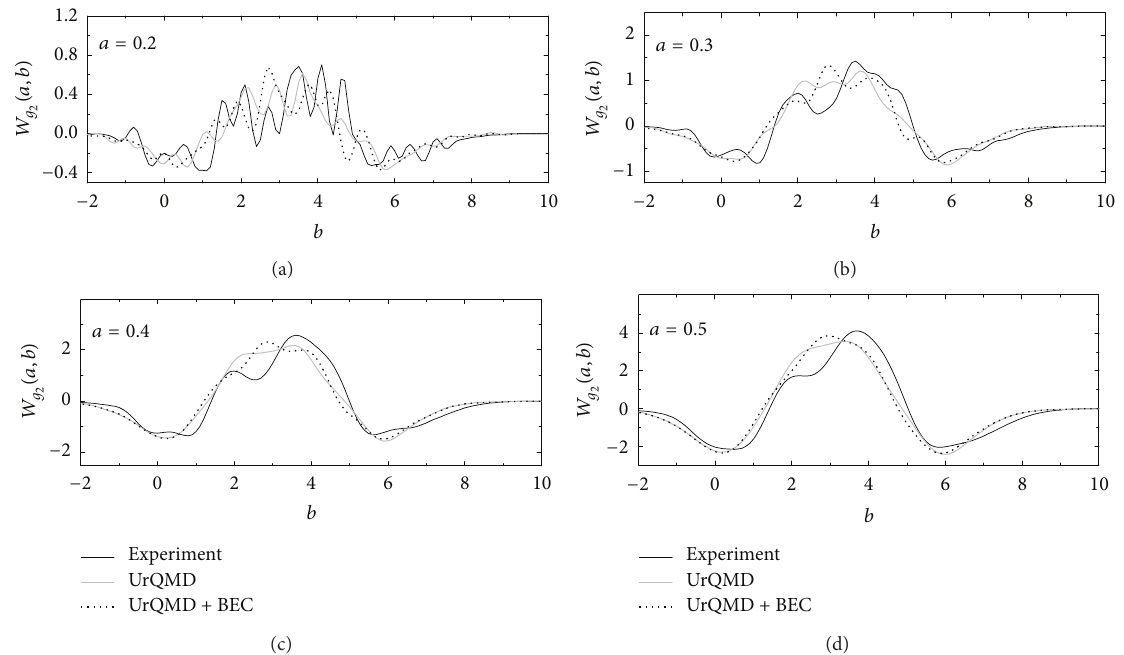
Figure 3: 𝑔 2 wavelet pseudorapidity spectra of 32 S-Ag/Br interaction at 200AGeV for different values of the scale parameter 𝑎 .